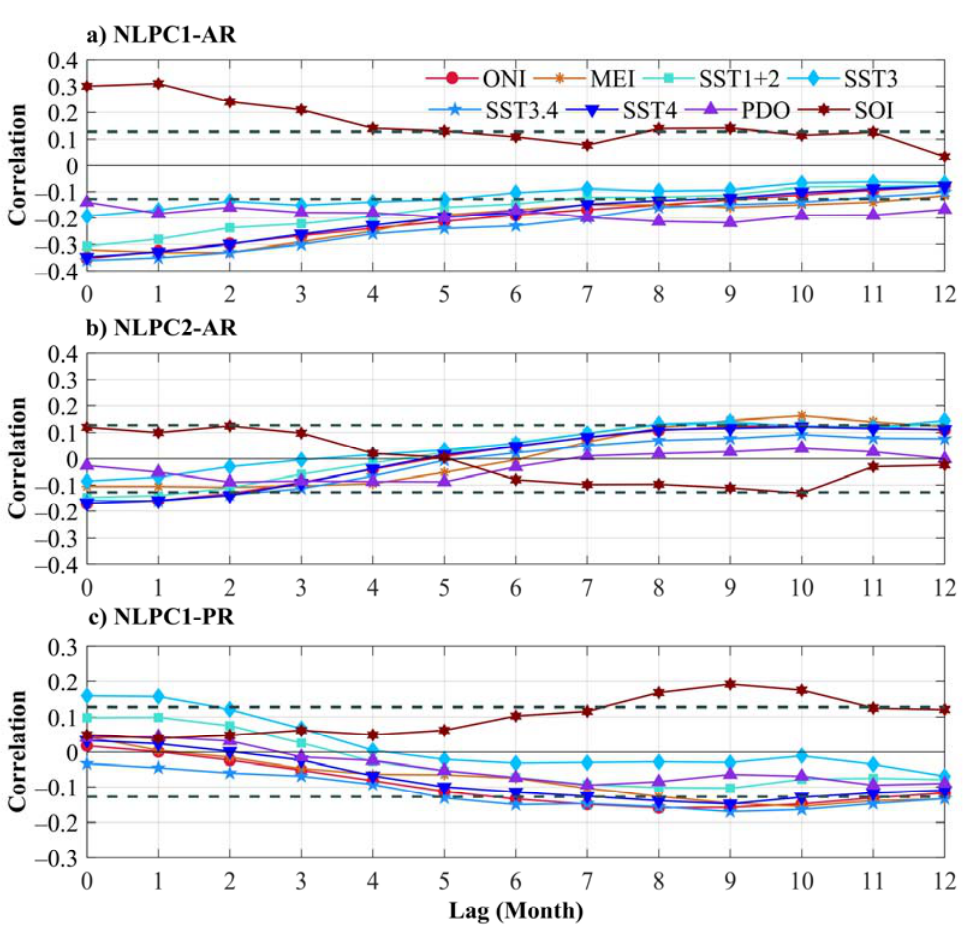
Figure 6. Correlations between NLPCs and climate indices. ( a ) NLPC1-AR, and ( b ) NLPC2-AR, and ( c ) NLPC1-PR. The dotted lines indicate a significance level of 0.01 ( ± 0.128).